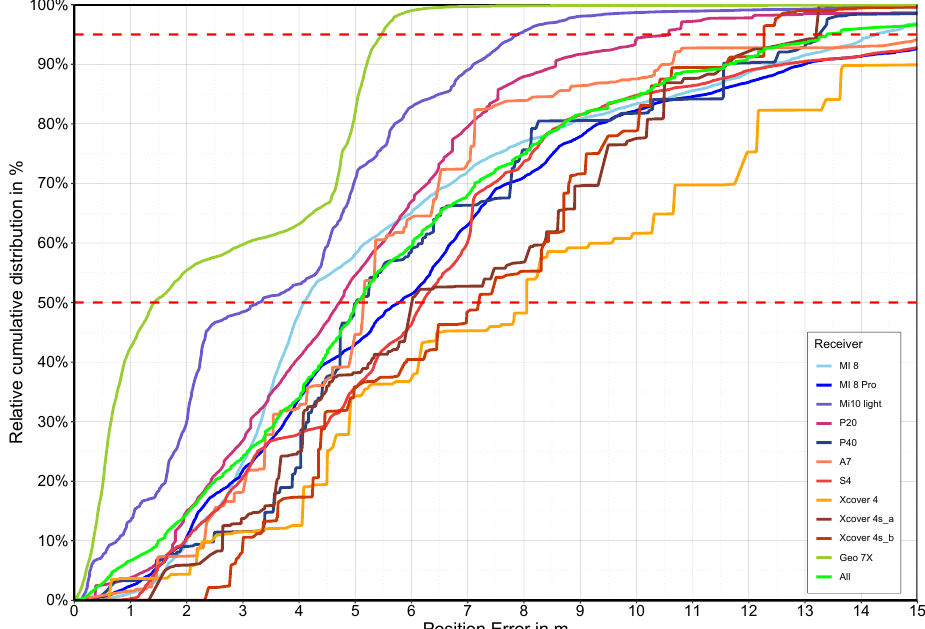
Figure 8. Relative cumulative GNSS accuracy distribution of different smartphones under different forest canopy conditions. Blue indicates smartphones that have multi-frequency capabilities, and red indicates smartphones that can only receive the L1/G1/E1/B1l bands.